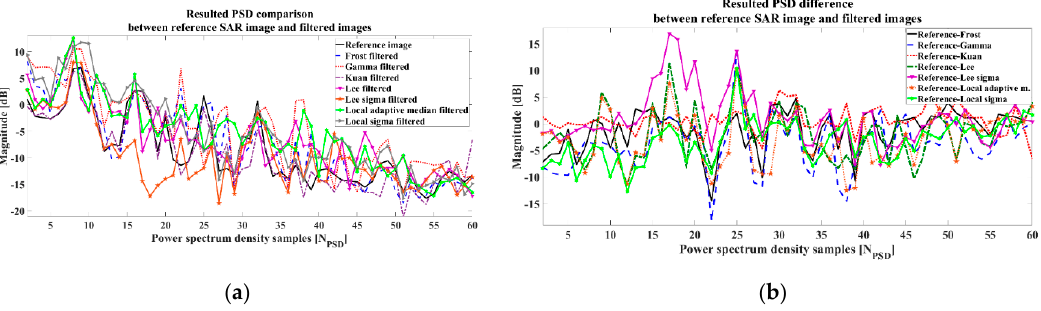
Figure 4. Resulting PSD modeling ( a ) comparison ( b ) difference with the reference SAR image.